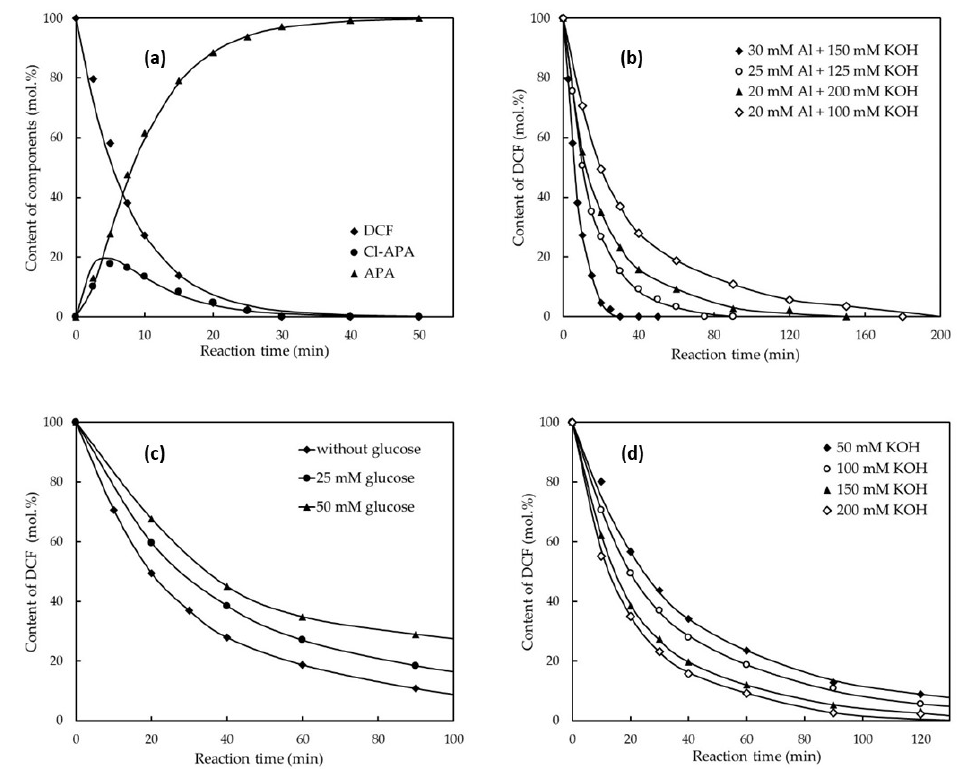
Figure 1. Comparison of HDC of DBF at 25 °C at conditions used in ( a ) run No. 1 in Table 2. ([DCF] 0 = 2 mM; [Al-Ni] 0 = 1.65 g L − 1 (30 mM Al); [KOH] 0 = 8.5 g L − 1 (150 mM KOH). Experimental (symbols) and model fit (solid lines); ( b ) different quantities of reagents, mentioned quantity of Al added in Al-Ni alloy, [DCF] = 2 mM; ( c ) with and without the addition of glucose, [DCF] 0 = 2 mM; 20 mmol L − 1 Al in Al-Ni alloy and 100 mmol L − 1 KOH; ( d ) using different amount of KOH (2 mmol L − 1 DCF + 20 mmol L − 1 Al in Al-Ni alloy). Table 2. HDC efficiencies of DCF using a different quantity and type of reductants.